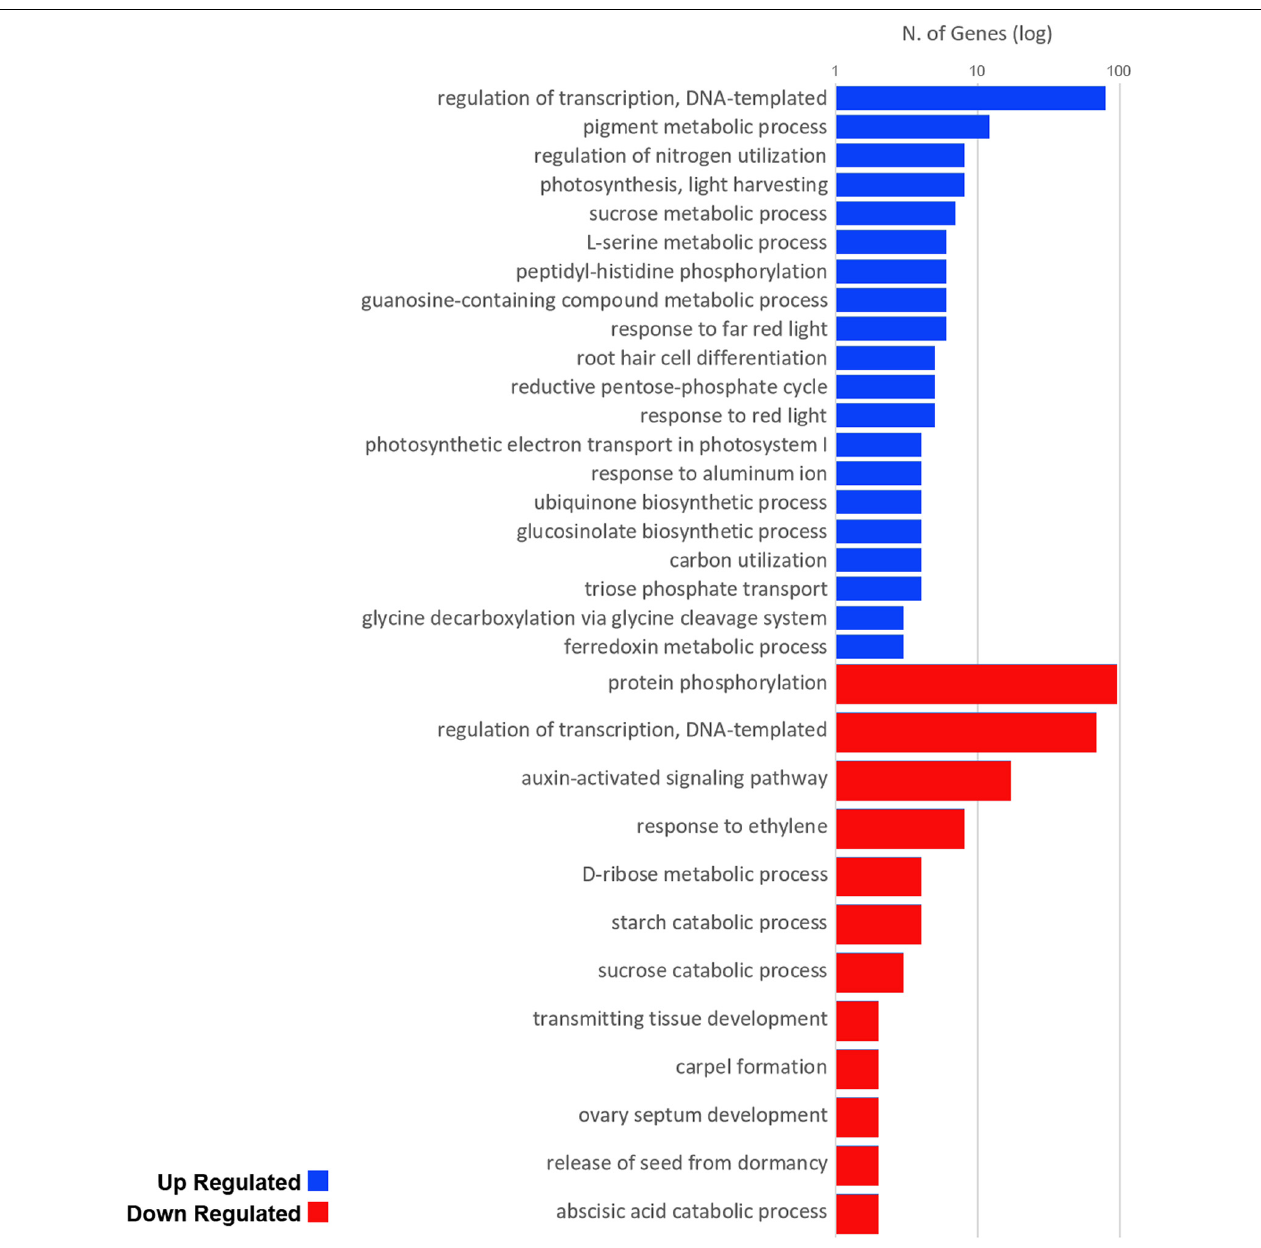
FIGURE 4 | Up (blue) and down (red) regulated overrepresented biological process GO terms present in our data set. Values are number of genes, scaled to log 10